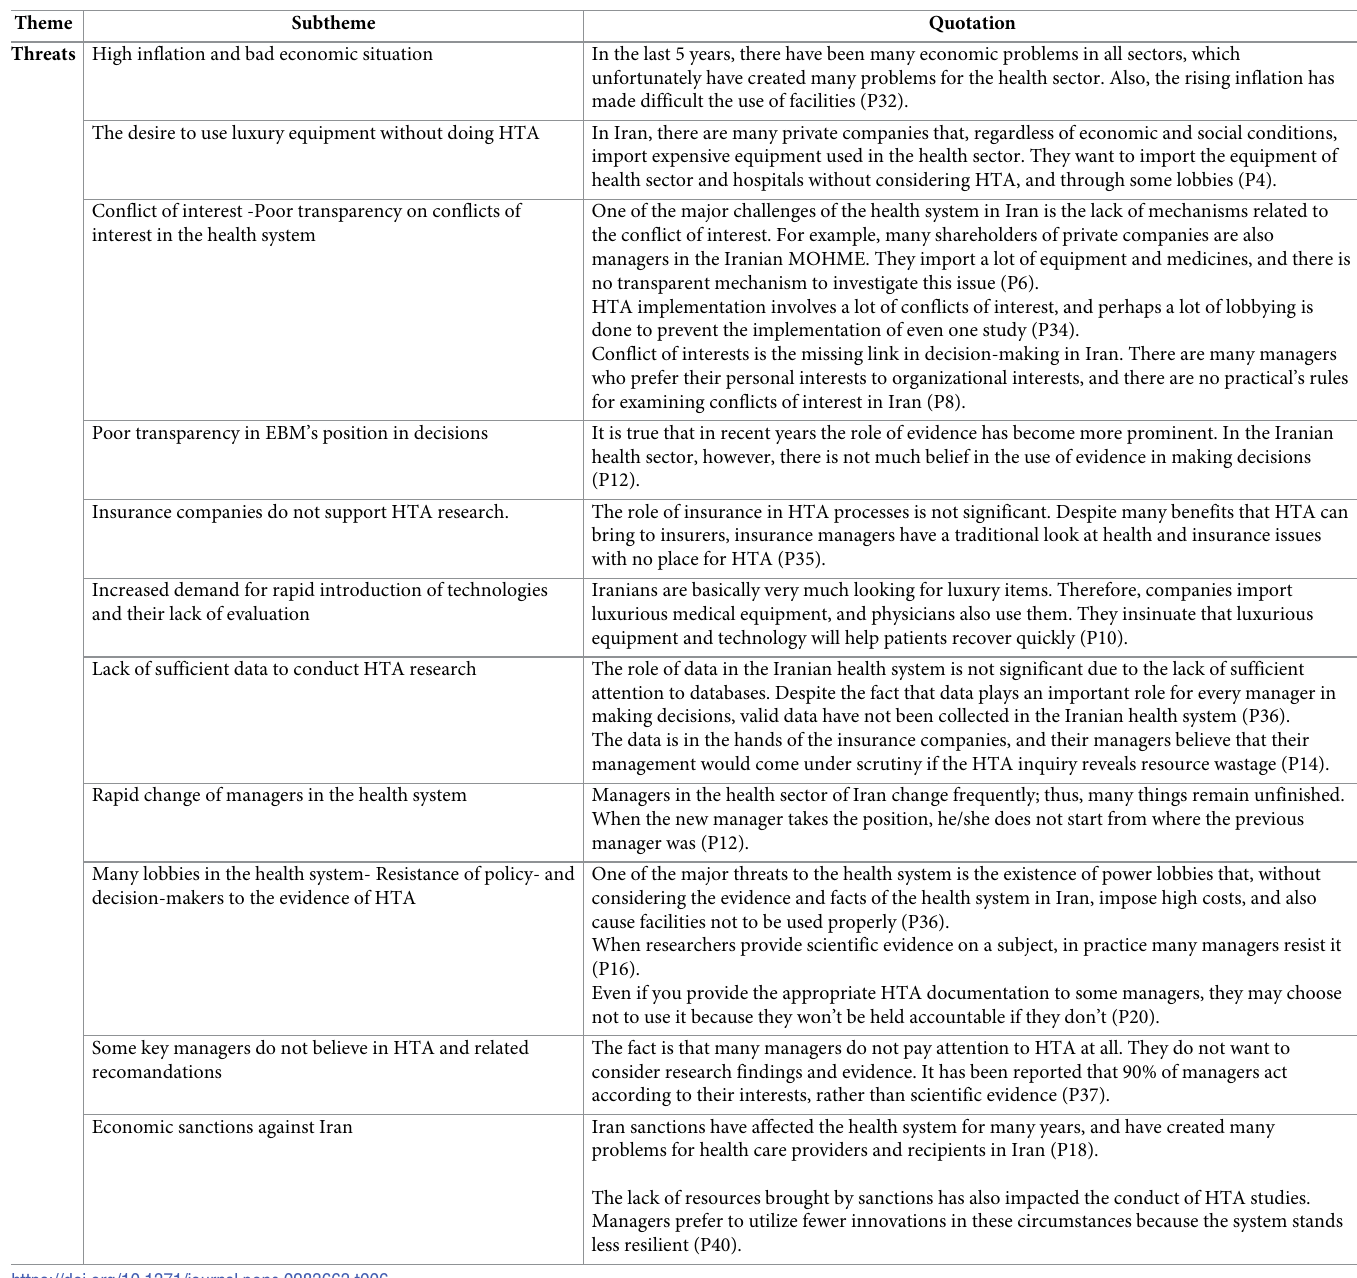
Table 6. The subthemes and quotations of the threats of developing the HTA in